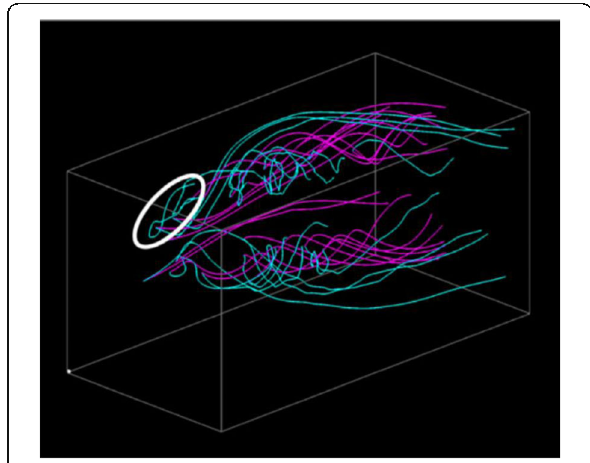
Fig. 13 Visualization example that displays streamline pairs in the same 3D